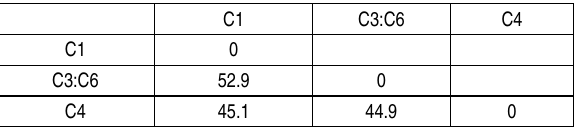
Table 21. Average linkage cluster matrix